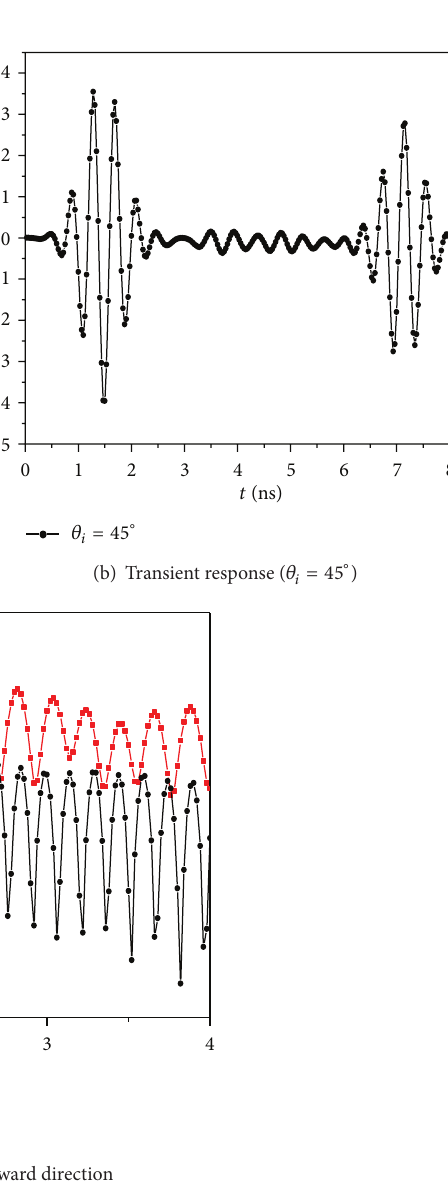
Figure 7: Backscattering from the 2D PEC rough surface for different incident